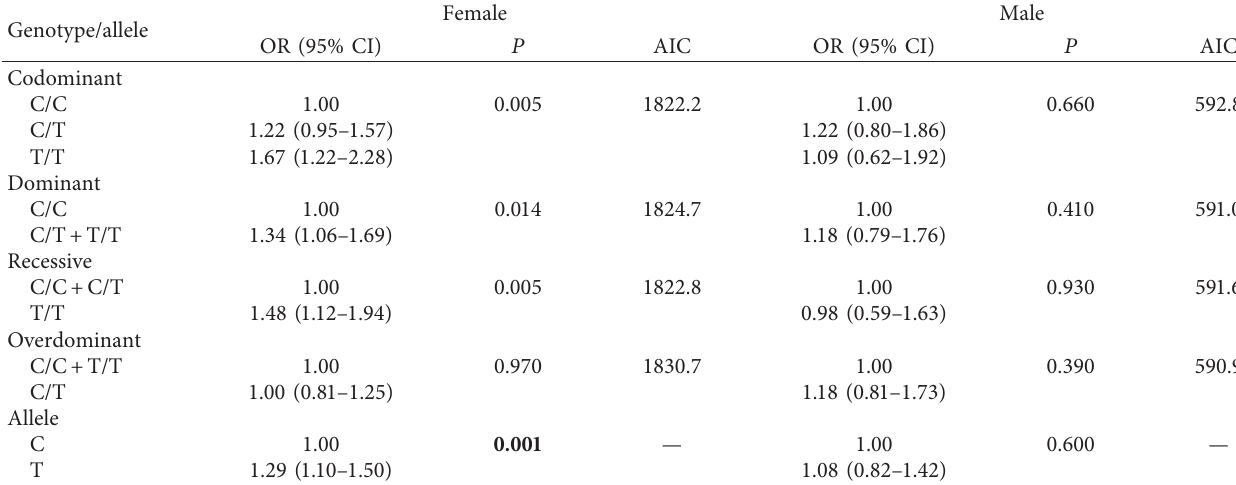
Table 7: Association between rs944289 polymorphism and PTC by gender.